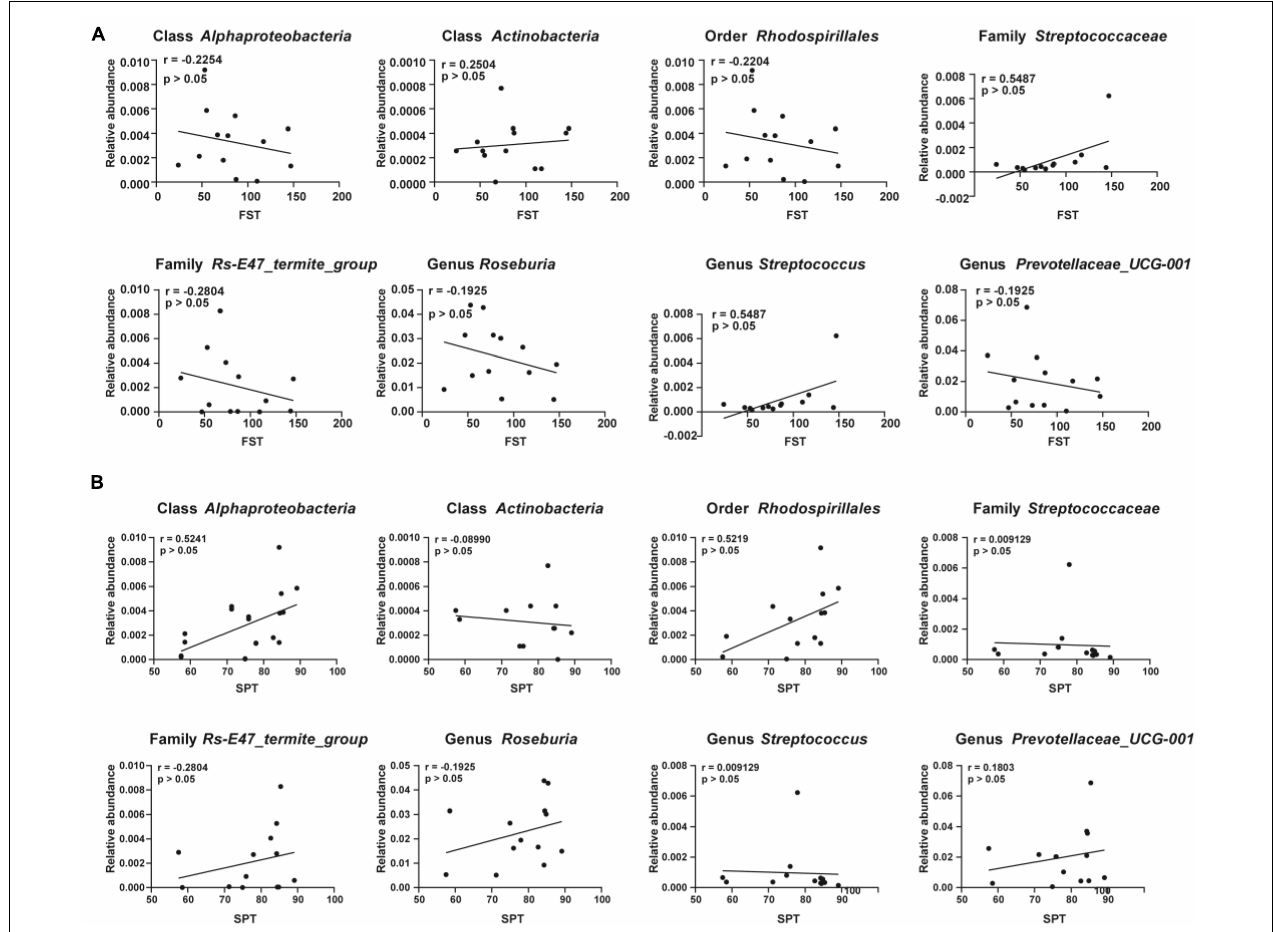
FIGURE 6 | Correlations between the relative abundance of various gut microbes and the depression-like behavior. (A) Correlation analyses between the relative abundance of gut microbiota and the immobility time of FST. (B) Correlation analyses between the relative abundance of gut microbiota and the value of SPT. Significant correlations were determined based on p < 0.05. FST, forced swimming test; SPT, sucrose preference